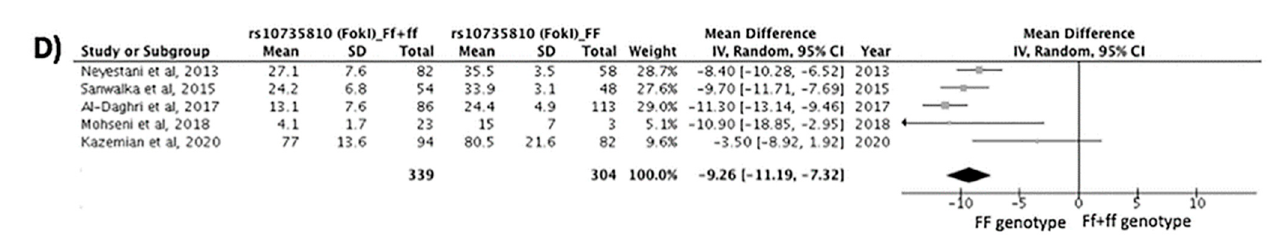
Figure 2. Meta-analysis of the association between gene variants in the vitamin D receptor ( VDR) gene and the response to vitamin D supplementation. ( A ) Association between the BsmI polymorphism and the response to vitamin D supplementation. Test for overall effect: Z = 0.24 ( p = 0.81). Test for heterogeneity: χ 2 = 6.31 ( p < 0.001), I2 = 9.4%. ( B ) Association between the TaqI polymorphism and the response to vitamin D supplementation. Test for overall effect: Z = 2.30 ( p = 0.02). Test for heterogeneity: χ 2 = 19.47 ( p < 0.001), I2 = 10%. ( C ) Association between the ApaI polymorphism and the response to vitamin D supplementation. Test for overall effect: Z = 0.48 ( p = 0.63). Test for heterogeneity: χ 2 = 1.24 ( p = 0.004), I2 = 7.7%. ( D ) Association between the FokI polymorphism and the response to vitamin D supplementation. Test for overall effect: Z = 9.39 ( p < 0.001). Test for heterogeneity: χ 2 = 2.47 ( p = 0.04), I2 = 5.9%.